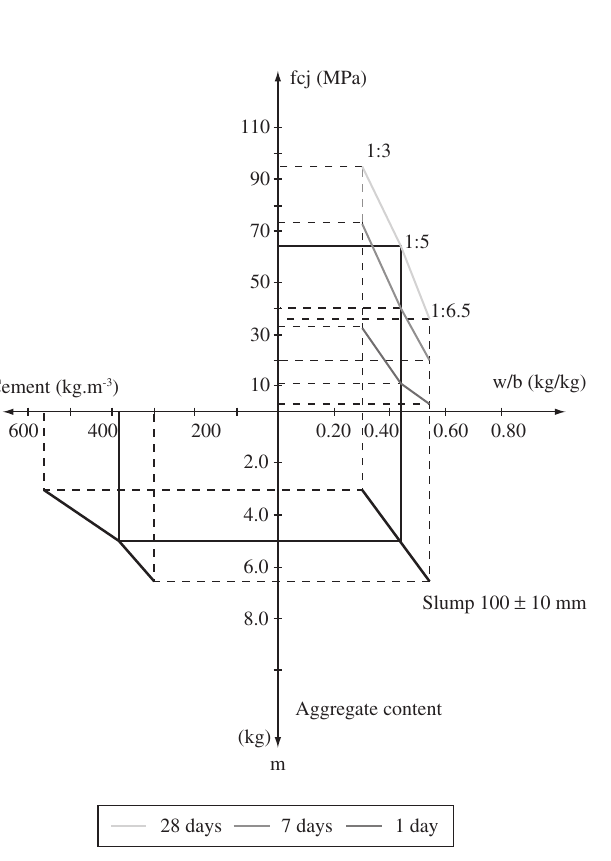
Figure 5. Dosage abacus to determine feature of the HPC for environments at low temperatures. Source: Lima 9 .